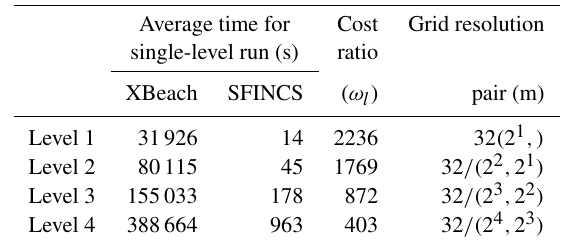
Table 5. Summary of average time taken to run SFINCS and XBeach at each level for the Myrtle Beach test case. As can be seen from Eqs. (B4) and (3), at every level (apart from the coarsest level) a pair of simulations at two different resolutions is required. These resolutions are shown in the “grid resolution pair” column, and we recall that the same resolutions are used in each